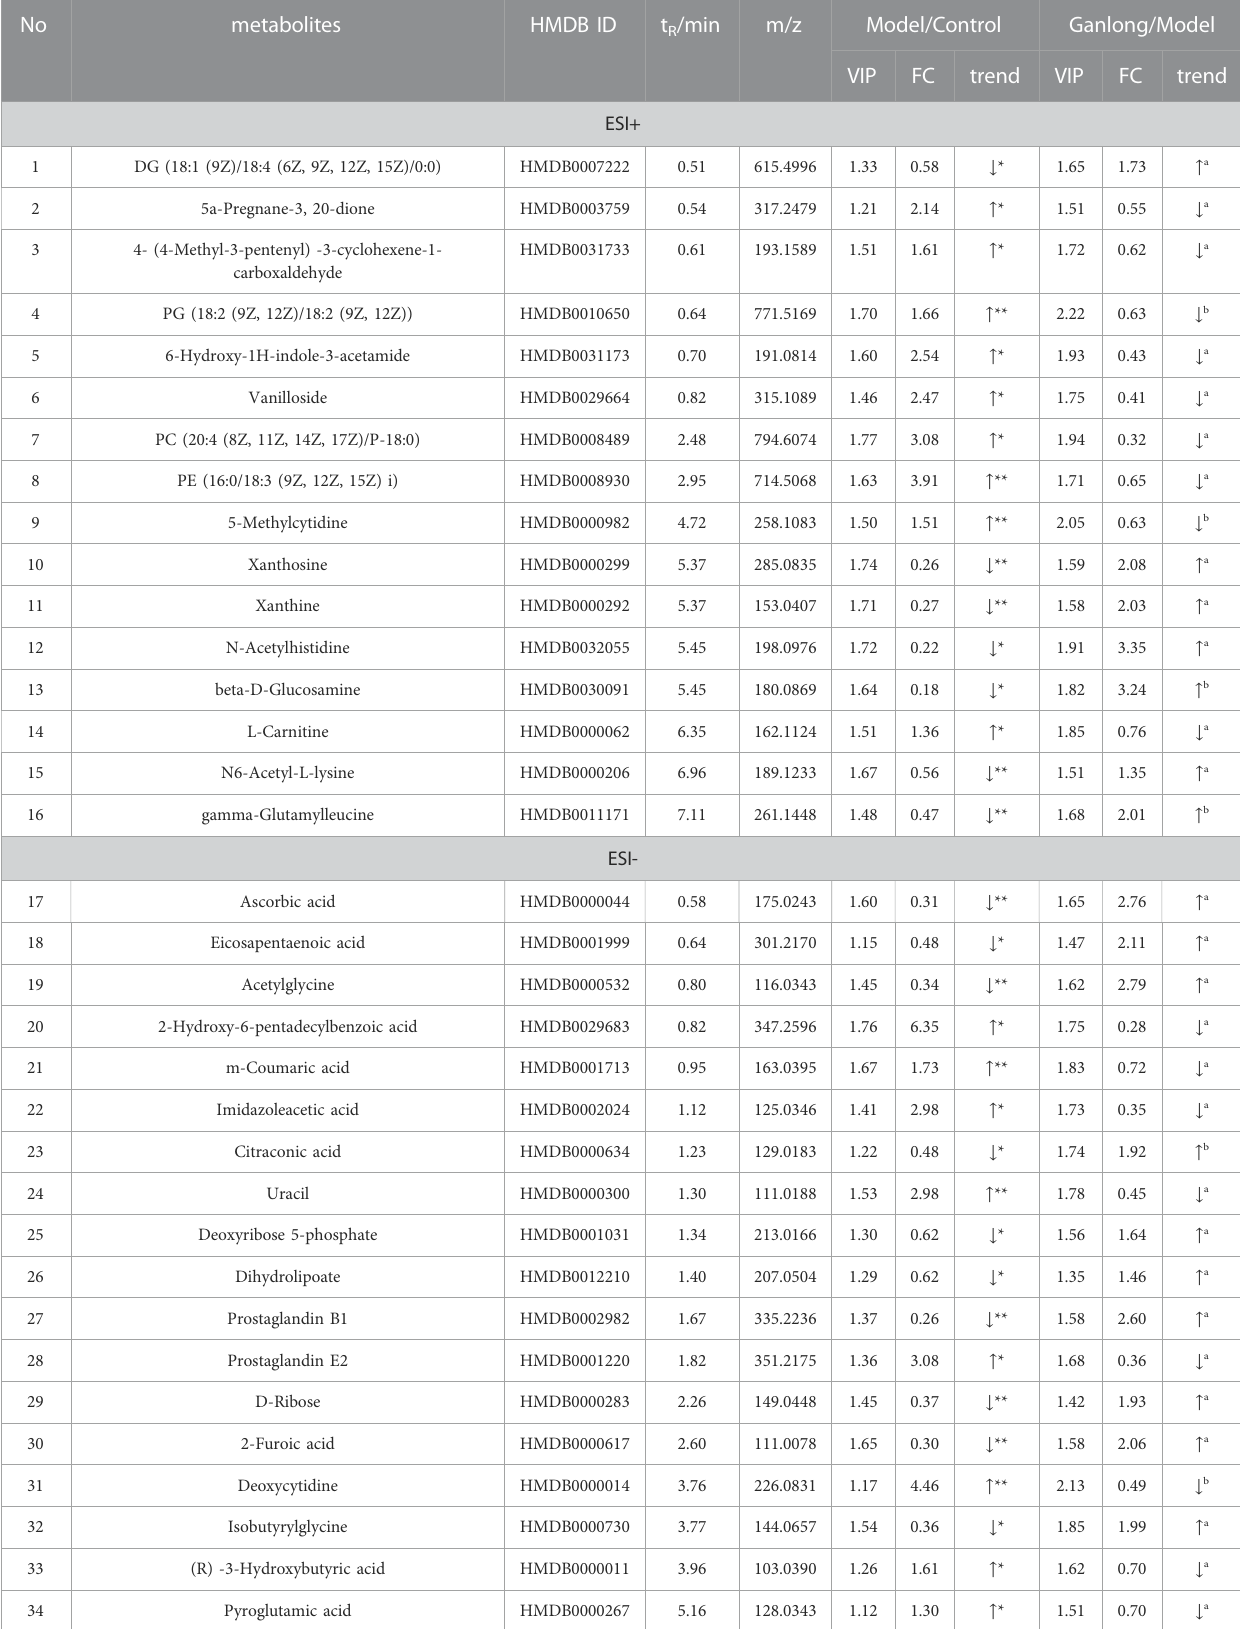
TABLE 1 Summary of the differential metabolites identi fi ed in the liver tissue of three